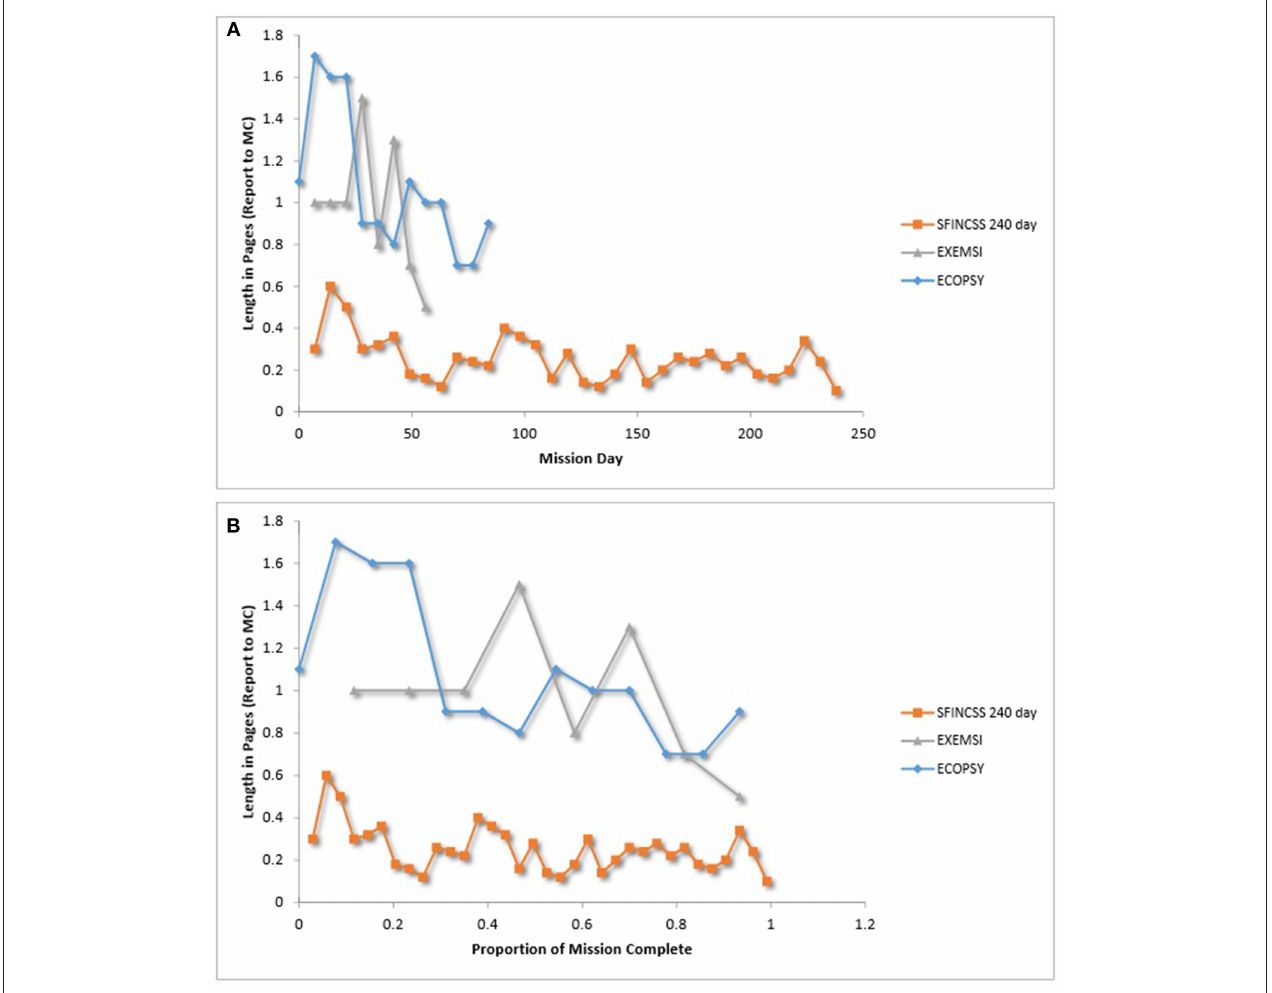
FIGURE 7 | (A) Commander report length over time. (B) Commander report length over relative time. Gushin et al. (1996b); Gushin et al. (1997), Gushin et al.